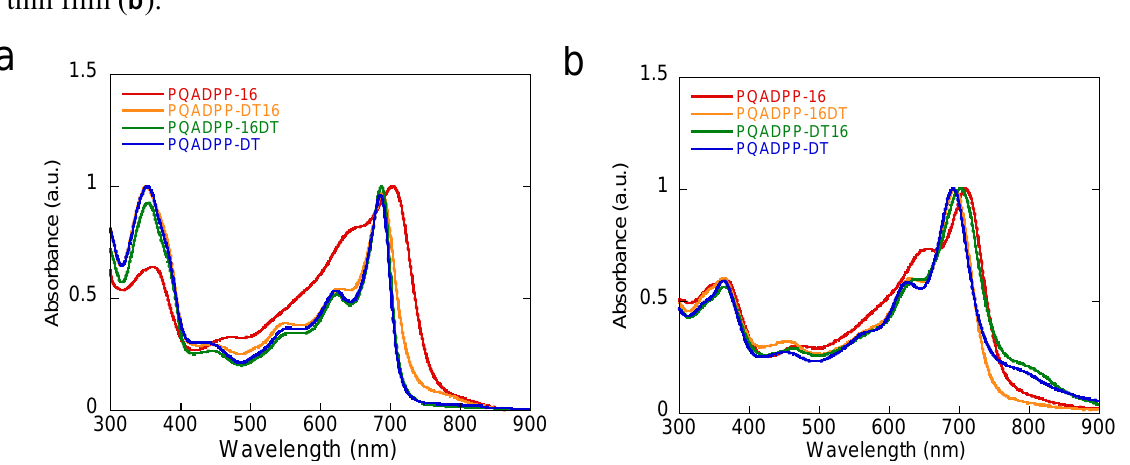
Figure 2. UV-Vis absorption spectra of the polymers in chlorobenzene solution ( a ) and in thin film ( b